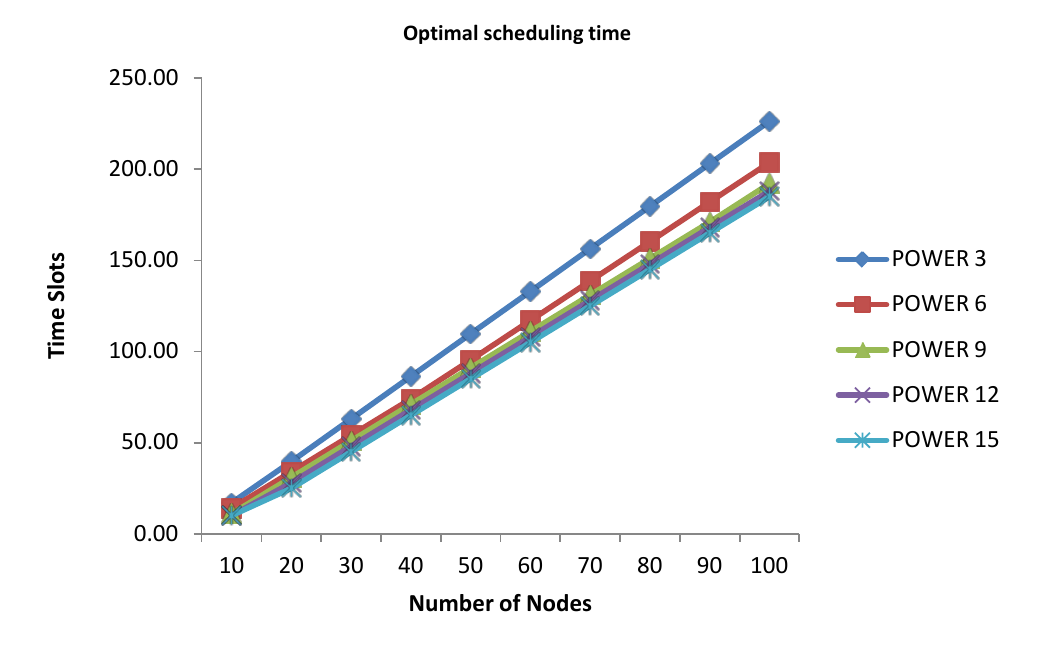
Figure 5. Optimal scheduling time in a linear topology with fixed